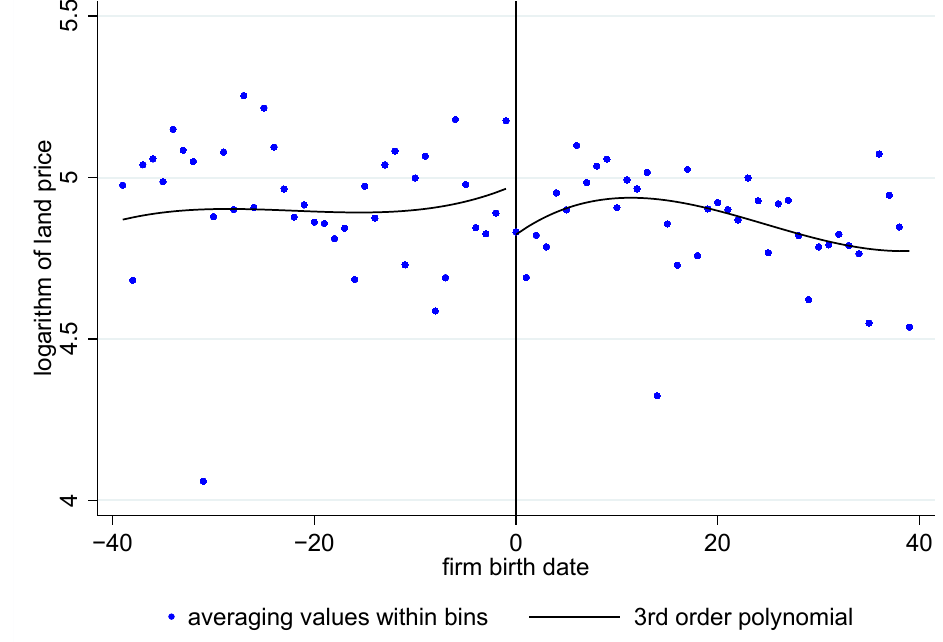
Figure 5. Land prices by month of entry around the tax collection reform.